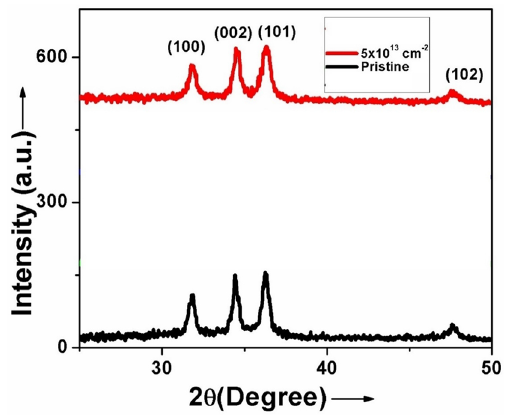
Figure 6. XRD patterns of pristine and 120 MeV Ag 9+ ions beam irradiated 5at.% ZnO:Ga thin films.